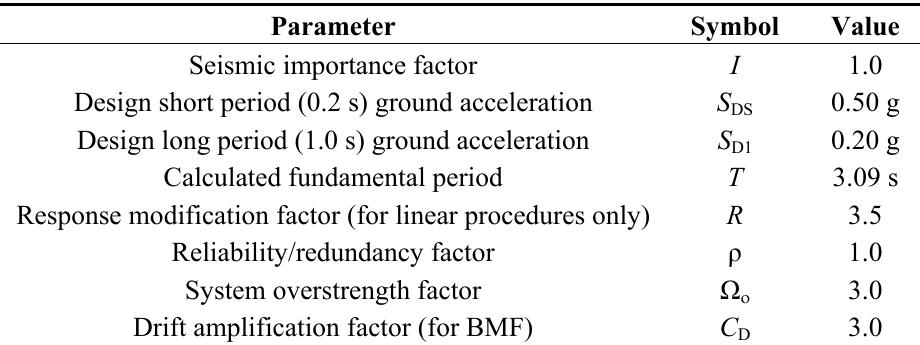
Table 1. Seismic Design